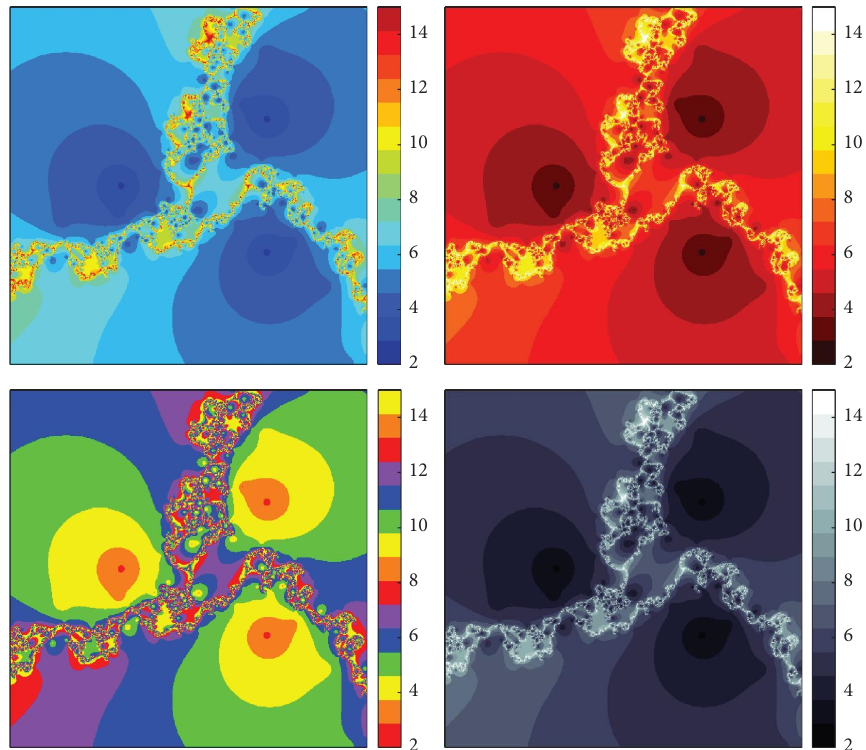
Figure 17: Examples of polynomiographs of diferent color maps for p